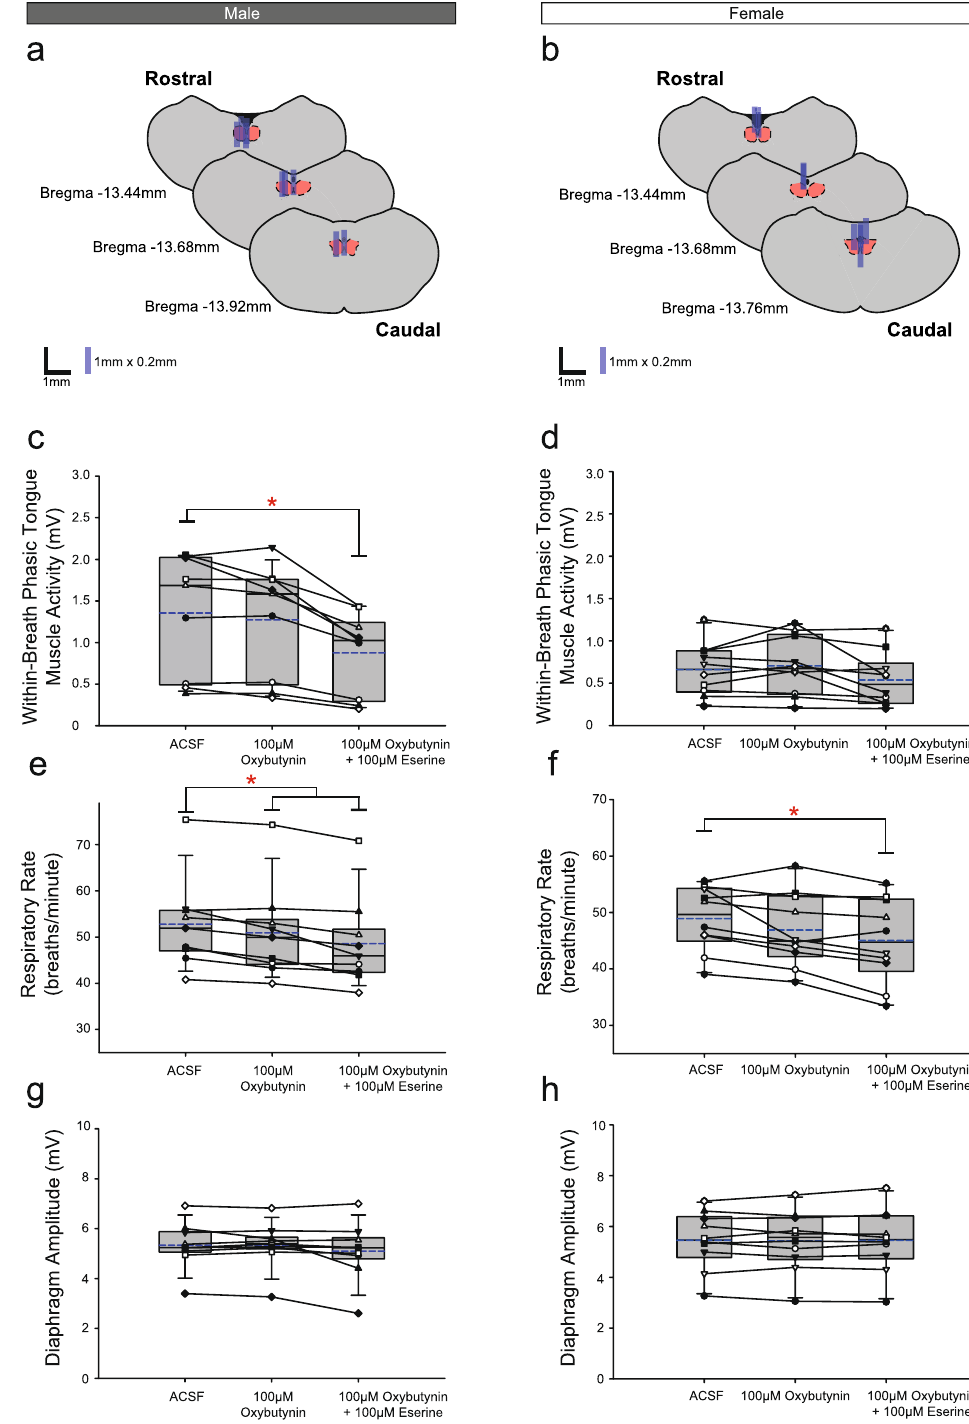
Figure 5. Group data from Protocol 1.2b : Microperfusion of 100 μM oxybutynin into the HMN with and without co-application of eserine (left column: male, n = 9; right column: female, n = 10). Schematic representations of coronal sections of medulla illustrating the distribution of probe sites across all experiments ( a , b ). Drawn to scale, the blue rectangles represent reconstruction of the sites of the microdialysis probes; overlap obscures some of the individual probe sites. Box and whisker plots show individual and group data (median [dashed line], mean [solid line] and 25th and 75th percentiles) for within-breath phasic tongue muscle activity ( c , d ), respiratory rate ( e , f ), and diaphragm amplitude ( g , h ). Each animal is indicated by a different symbol. *, indicates p < 0.05 compared to baseline ACSF